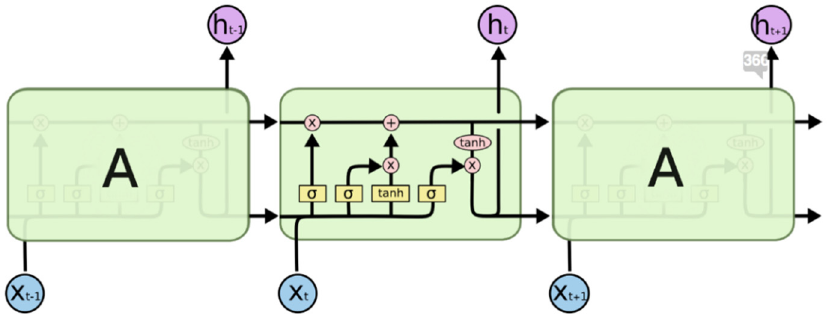
Figure 3. LSTM cell structure [40].